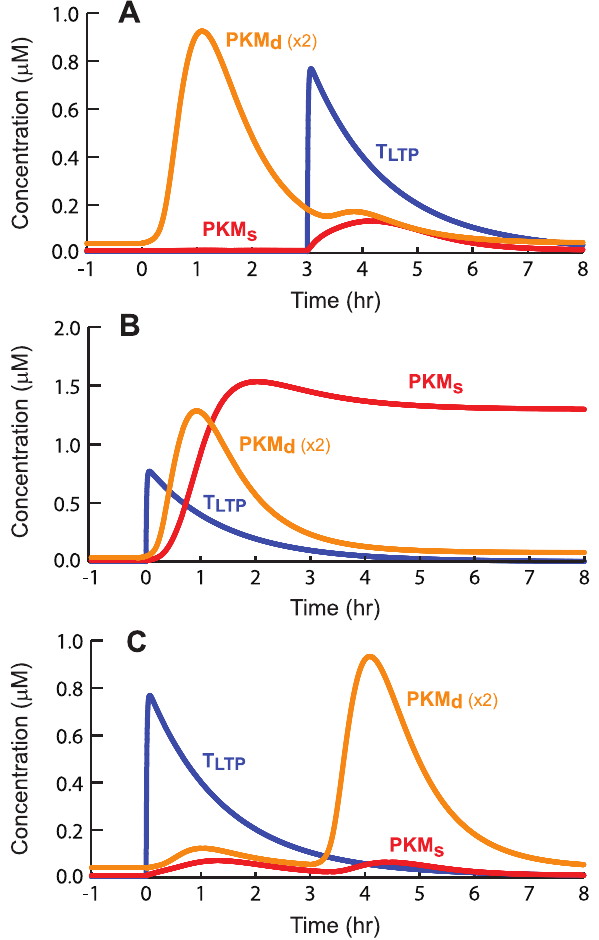
Figure 6. Simulated dynamics of key molecules in an STC protocol. A , Time courses of dendritic and synaptic PKM and the LTP tag, for WTET following STET by 3 h. B , WTET follows STET by 10 min. C , WTET precedes STET by 3 h.